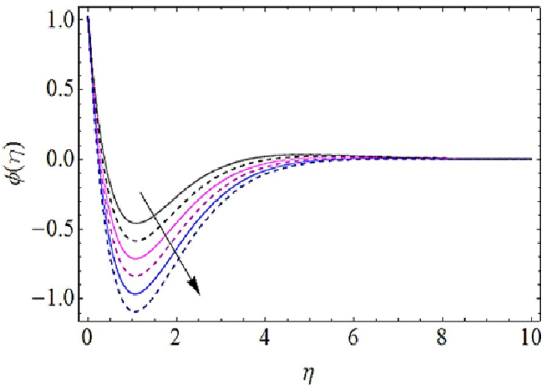
Fig 12. Concentration characteristics for various values of Lewis number.